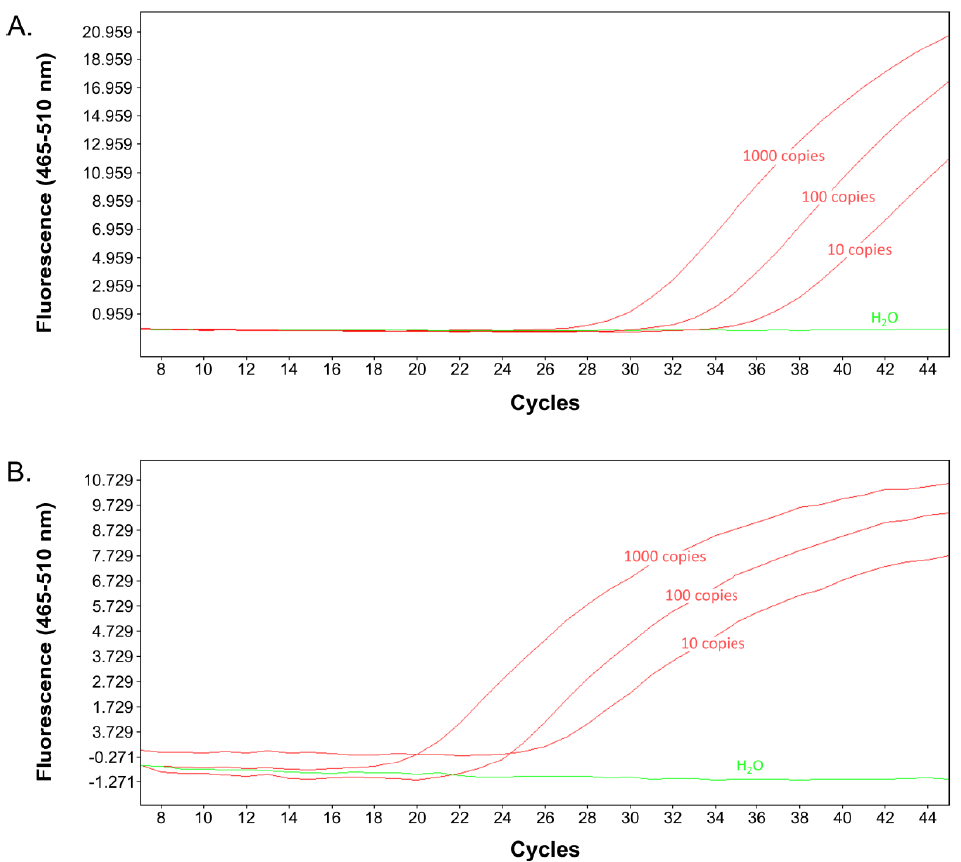
Figure 4. Comparison of the 16S rRNA SNP-PCR assay (DNA-only) with the RT-16S rRNA SNP- PCR assay (DNA+RNA). Total DNA or total DNA+RNA isolated from exponentially growing cells of B. anthracis or B. cereus , respectively, were used for PCR amplification of 16S-BA-allele DNA ( A ) or additionally after reverse transcription of 16S rRNA (ribosomal RNA) ( B ). Representative amplification curves (from n = 3 with similar results) are